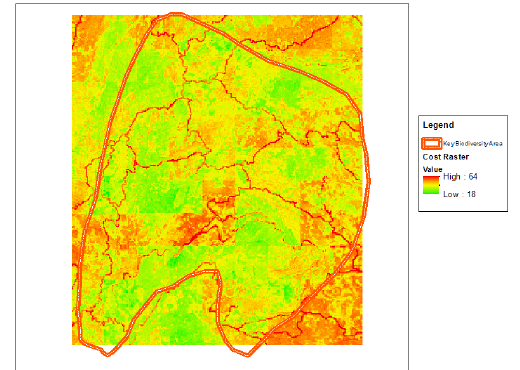
Figure 5. Cost Raster visualizes the cost in each cell for connecting forest fragments in Mt. Lantoy KBA